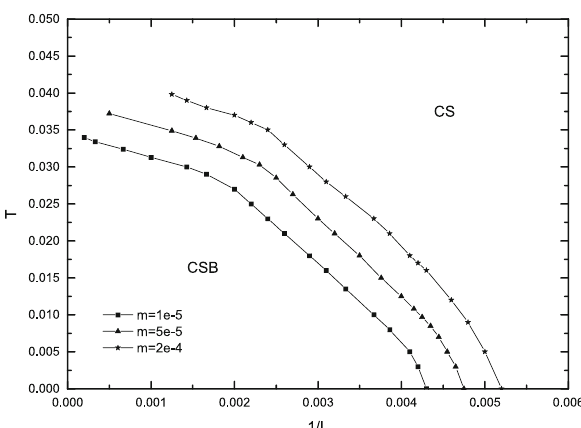
Fig. 8 The values of thermal parameters with different mass at L = 300